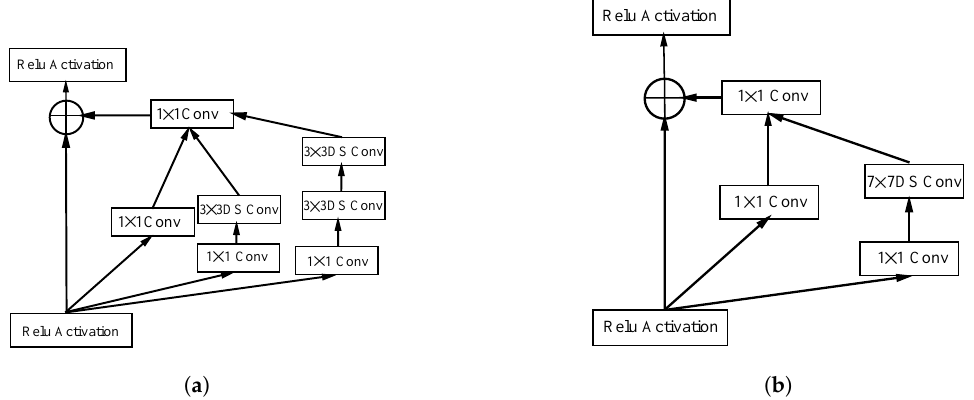
Figure 3. ( a ) Modified structures of InceptionResnet-A. ( b ) Structures of InceptionResnet-B of InceptionResNetV2 model.